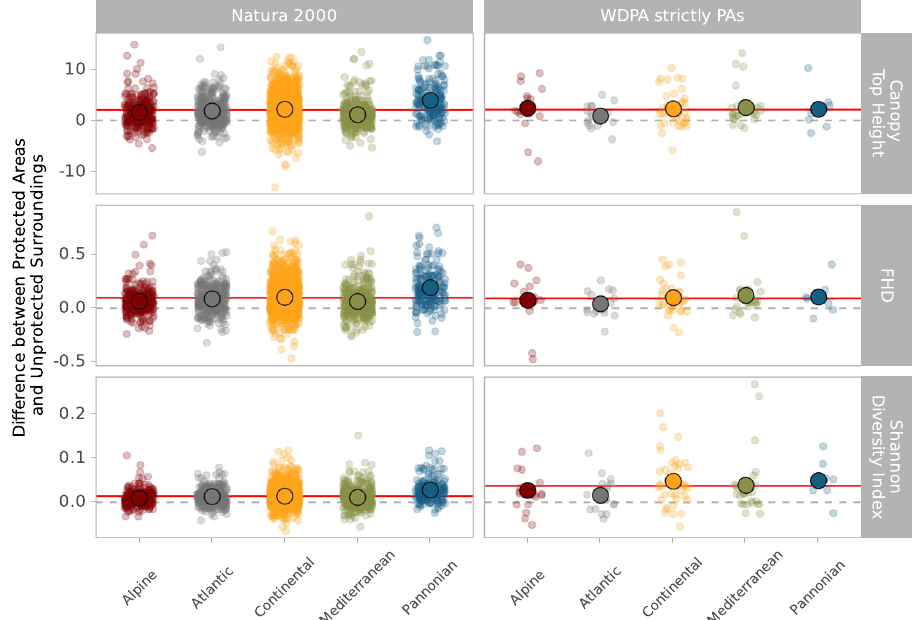
Fig. 3 Differences between Protected Areas and Unprotected Surroundings for different biogeographical regions. Canopy Top Height, Foliage Height Diversity and Shannon Diversity Index differences between forests within Protected Areas and their respective Unprotected Surroundings, separated according to the designation of the PA: Natura 2000 sites and strictly protected sites according to the World Database on Protected Areas (WDPA). Different columns refer to biogeographical regions 96 shown in Fig.S4. The horizontal red line is the European Union (EU) average difference, the big circles represent the regional averages, and the small dots are individual